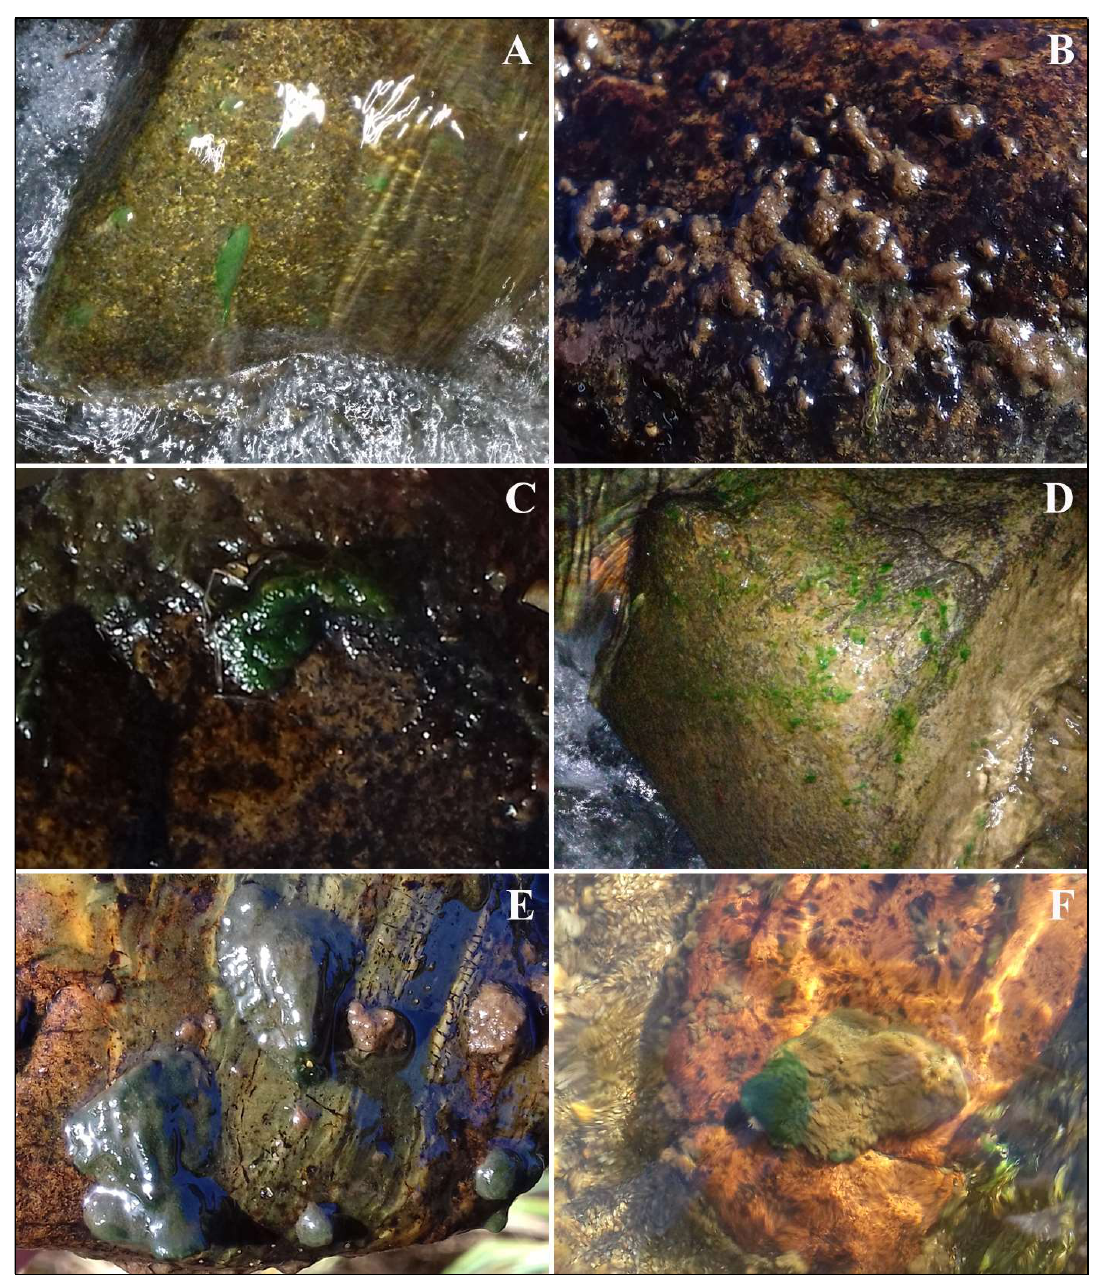
Figure 2. Benthic macroalgae found in the Samokovsa River; A) Cladophora glomerata ; B) Audouinella chalybea ; C) Microspora amoena ; D) Ulothrix zonata ; E) Microcoleus favosus ; F) Vaucheria sp. (photos by A. Mitrović,